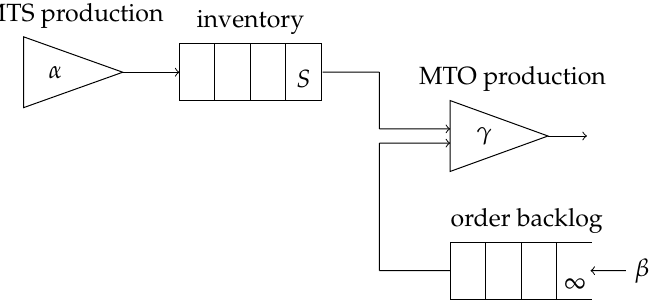
Figure 1. Generic inventory model. MTS, make-to-stock; MTO,